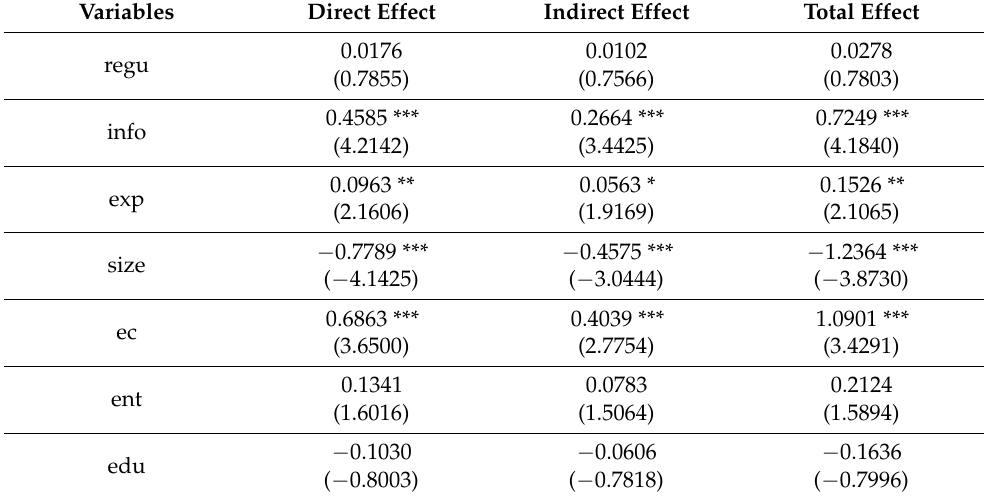
Table 8. First robustness test